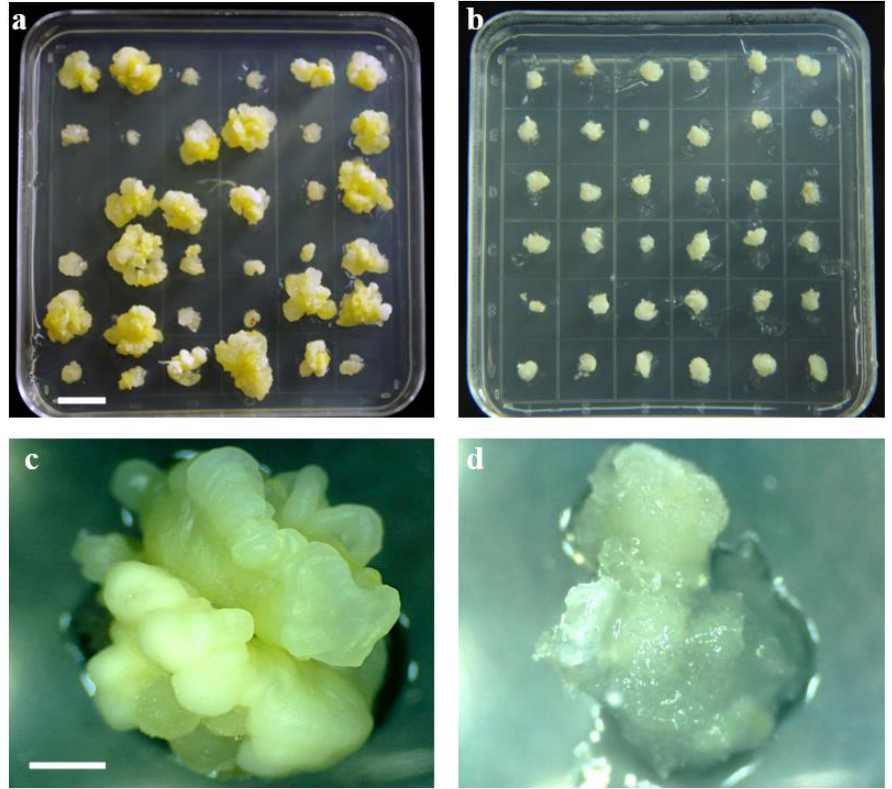
Figure 1. The calli induced from different doubled haploid lines in the IBM Syn10 DH population. ( a , c ) show the embryogenic callus (EC). ( b , d ) exhibit the non-embryogenic callus (NEC). Bar scale is 1 cm in ( a , b ) and 3 mm in ( c , d ).